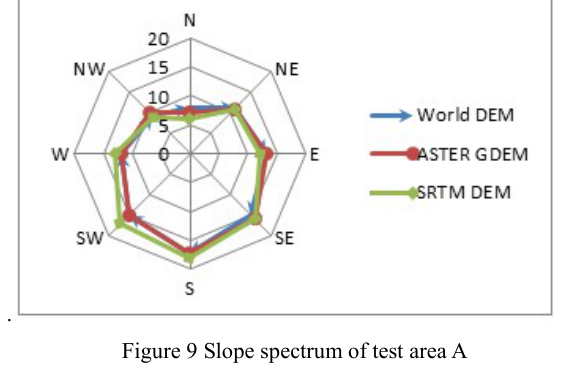
Figure 7 Slope loss statistical graph of test area A